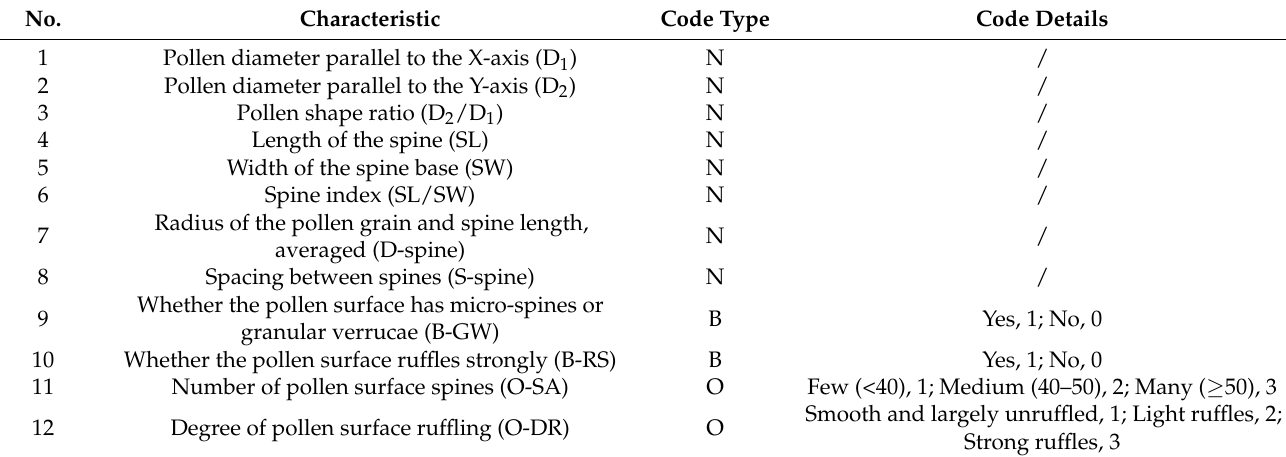
Table 2. Twelve pollen traits and their codes for Hibiscus syriacus